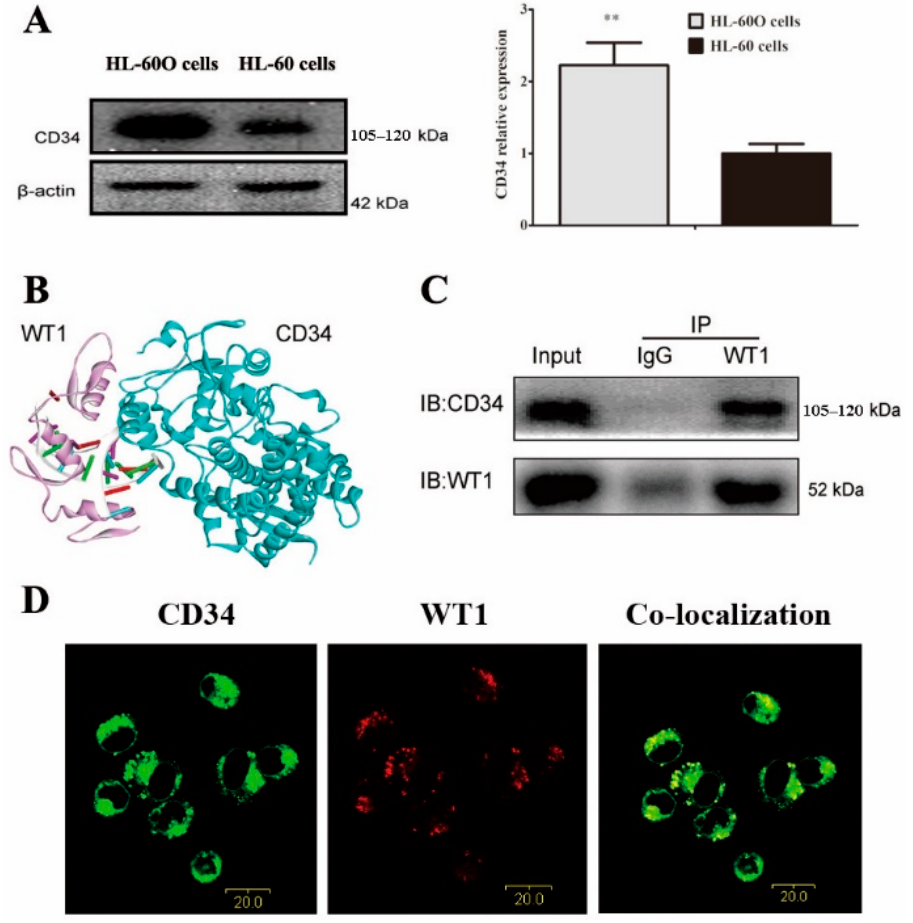
Figure 2. The protein–protein interactions between WT1 and CD34 protein. ( A ) CD34 protein expression was detected by Western blot in HL-60 cells and HL-60O cells ( n = 3). The data were presented as the mean ± SD ( n = 3). ** p < 0.01 compared to the parent HL-60 cells. The protein–protein interactions between WT1 and CD34 were indicated by ( B ) Zdock (the red lines represent Zn finger) and ( C ) Western blot in CO-IP experiment, and ( D ) co-localization in immunofluorescent staining.